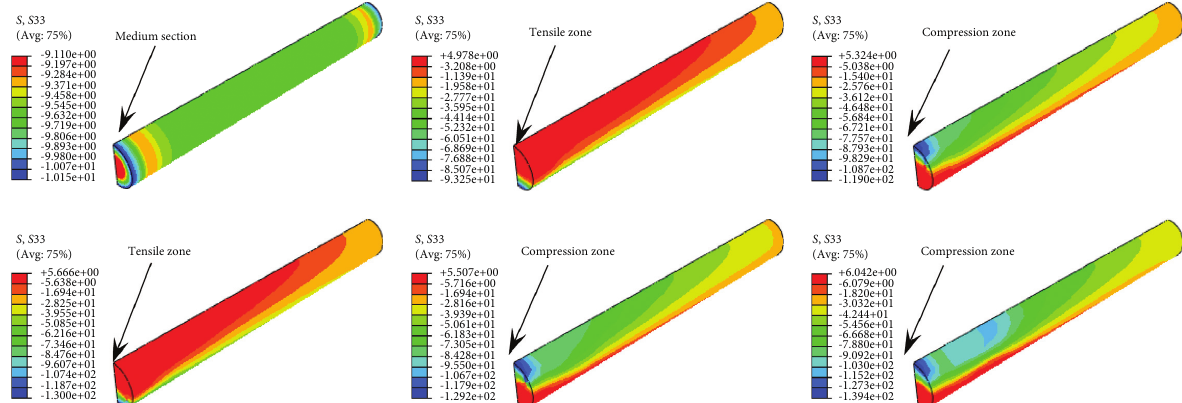
Figure 19: The longitudinal stress distribution of concrete in the